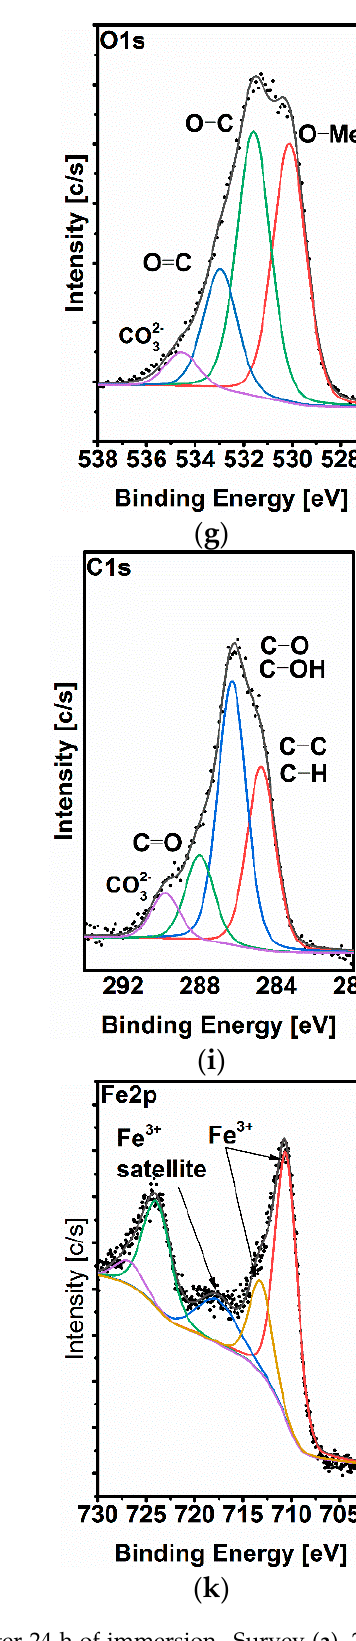
Figure 10. XPS analysis carried out after 24 h of immersion. Survey ( a ), 200 steel ( b , d , f , h , j ) and 300 steel ( c , e , g , i , k ).